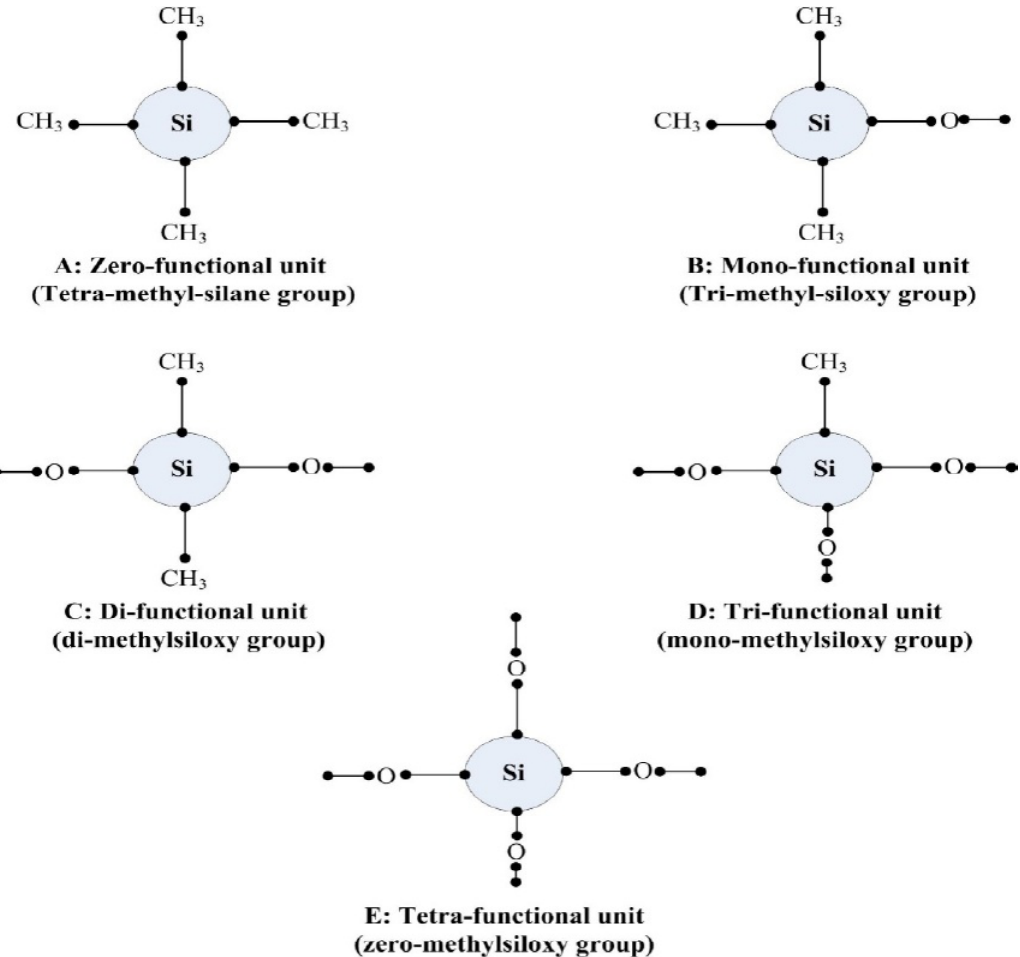
Fig. 2. Silicone structural